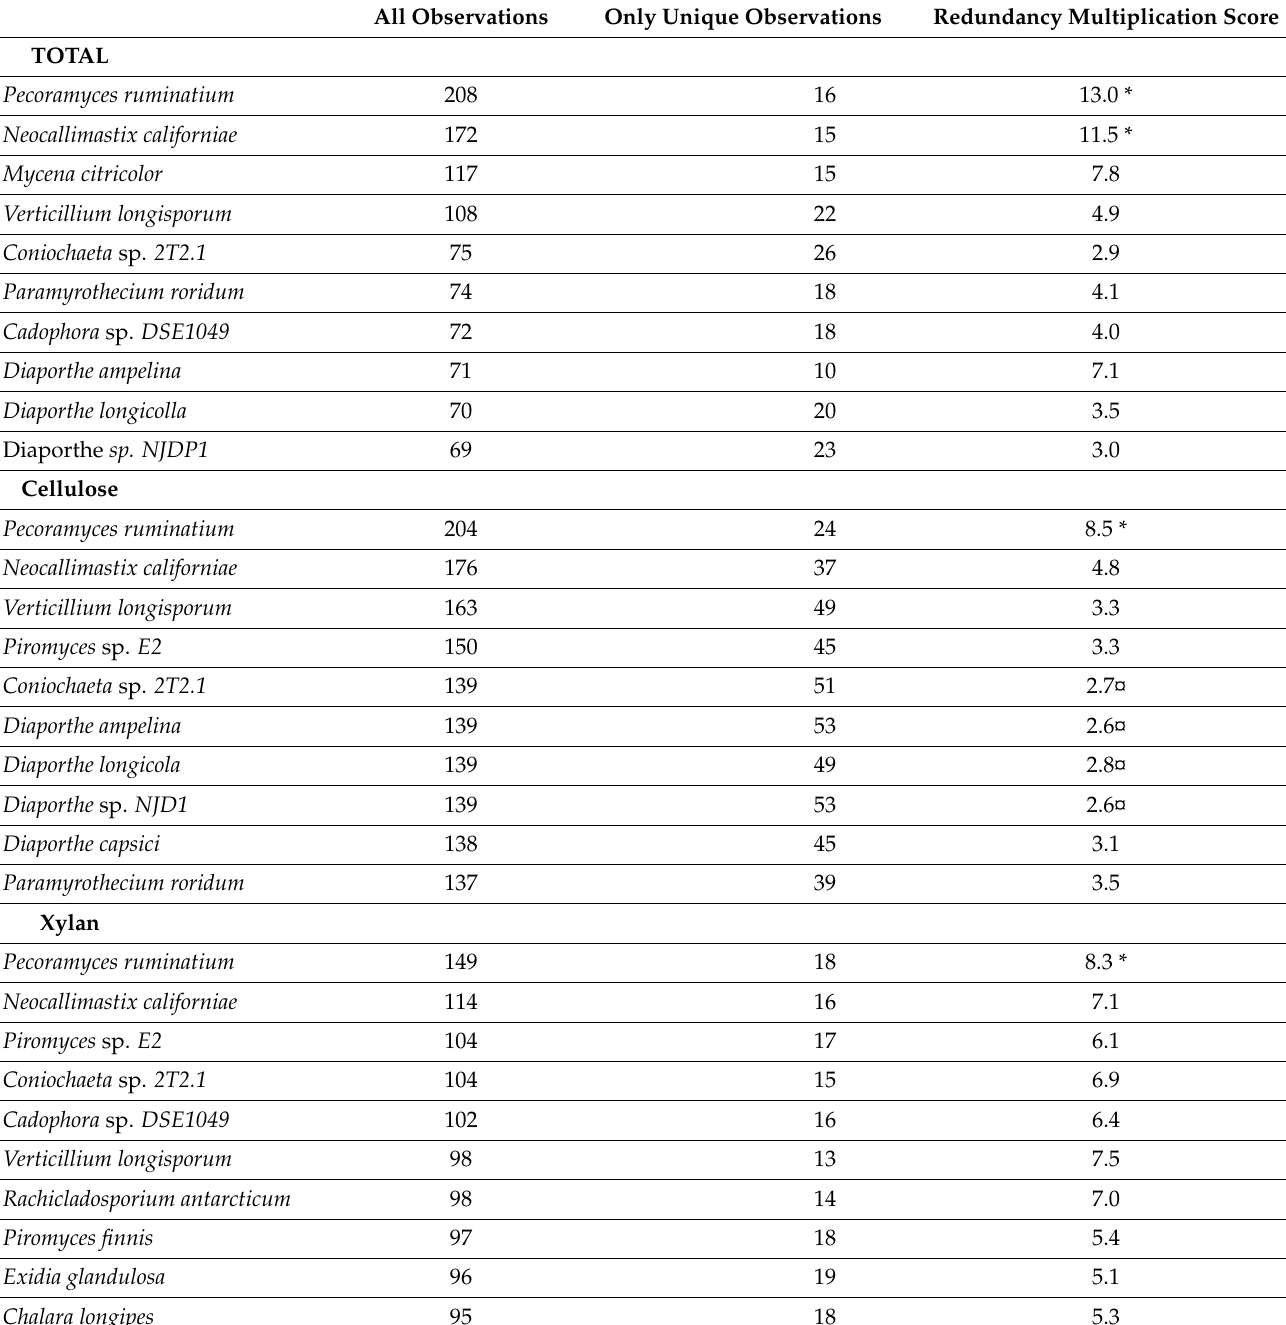
Table 4. Left column is names of top scoring sets of species with total-ranked observations (including redundant observa- tions); the scores are given in second column. The third column from the left is the number of unique “Function;Family” observations of the same sets of degrading capacity Top ranking species. The right-hand column is the ratio, Redundant over Unique observations, named as Redundancy Multiplication Score. * marks the species/substrate with the strongest (>8) Redundancy Multiplication factor; ¤ marks the species with the lowest (<3) Redundancy Multiplication